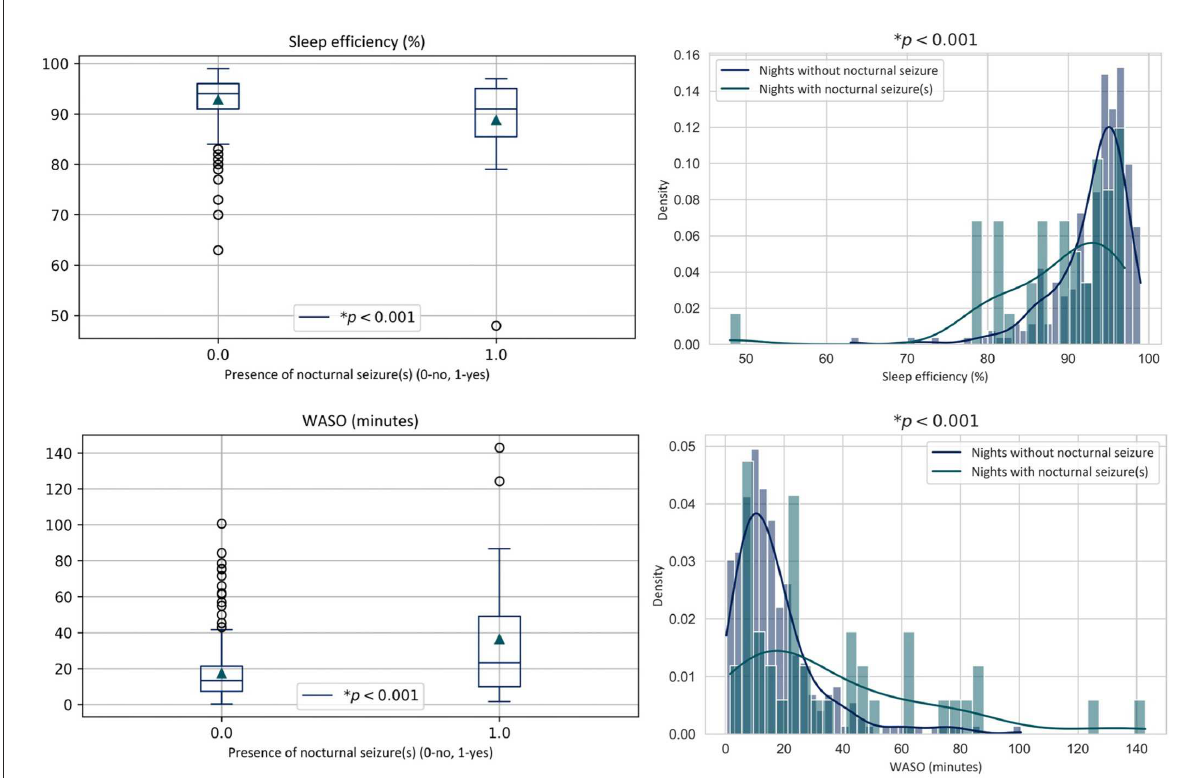
FIGURE5 Sleep metric distributions of all recordings containing at least one clinical nocturnal seizure vs. those with no nocturnal seizure. WASO, time in wake after sleep